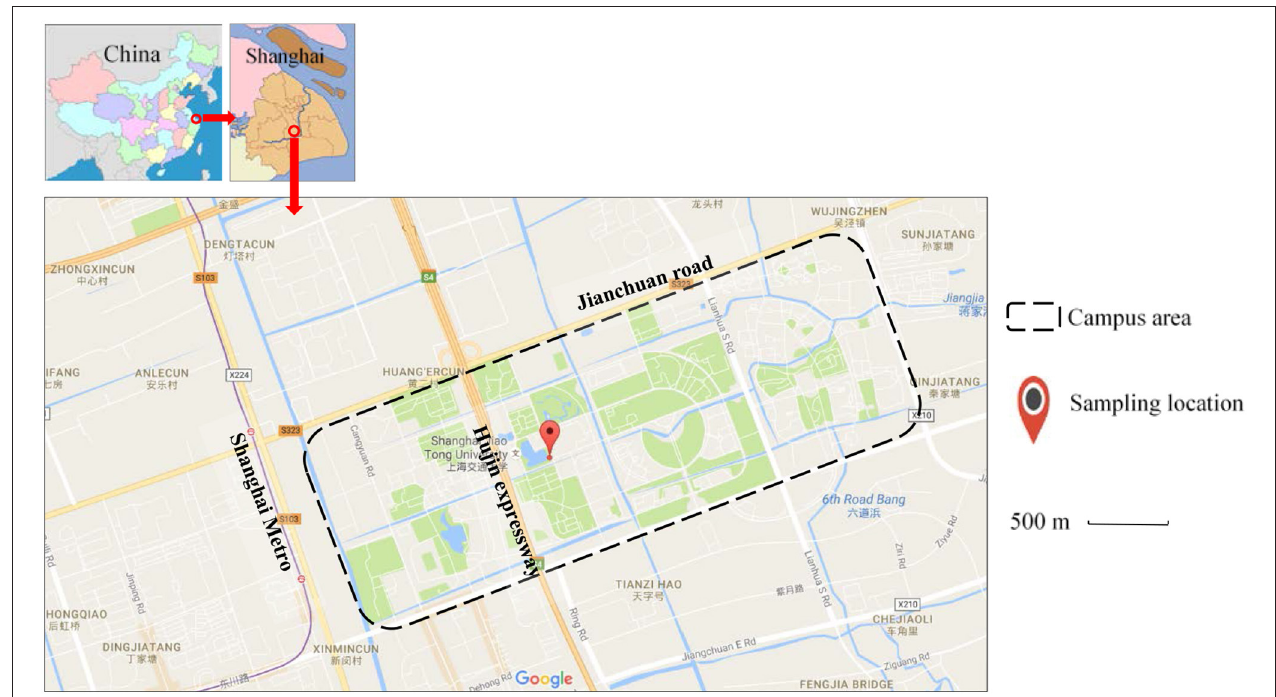
FIGURE 1 | Sampling